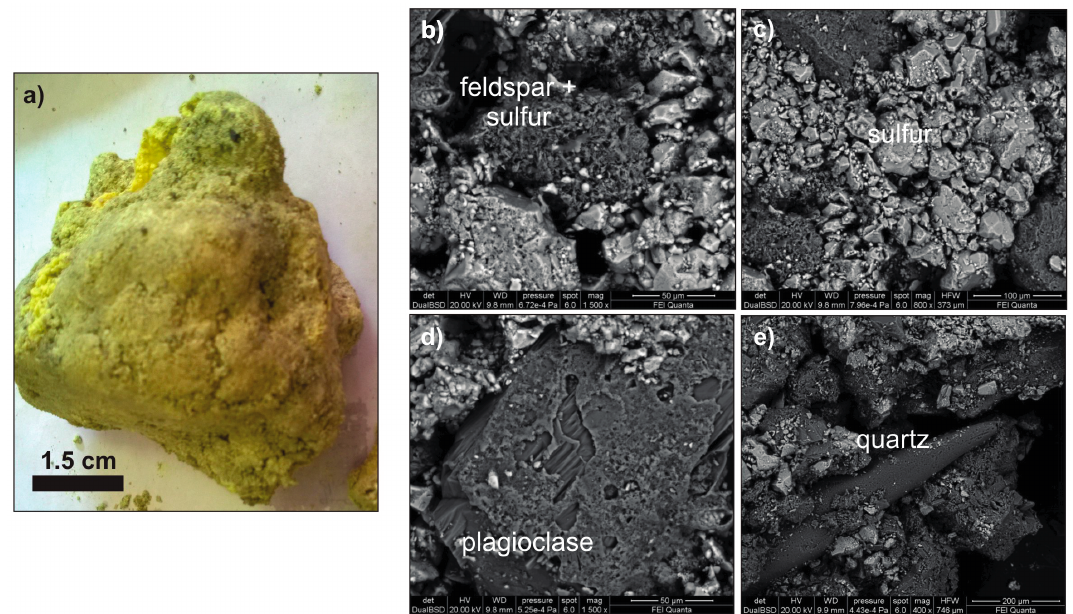
Figure 9. ( a ) macroscopic rock image of ST2BNR1 sample. Sand composed of quartz, K-feldspar, plagioclase, and barite cemented by sulfur. ( b – e ) SEM images showing the texture of minerals that form the sample.